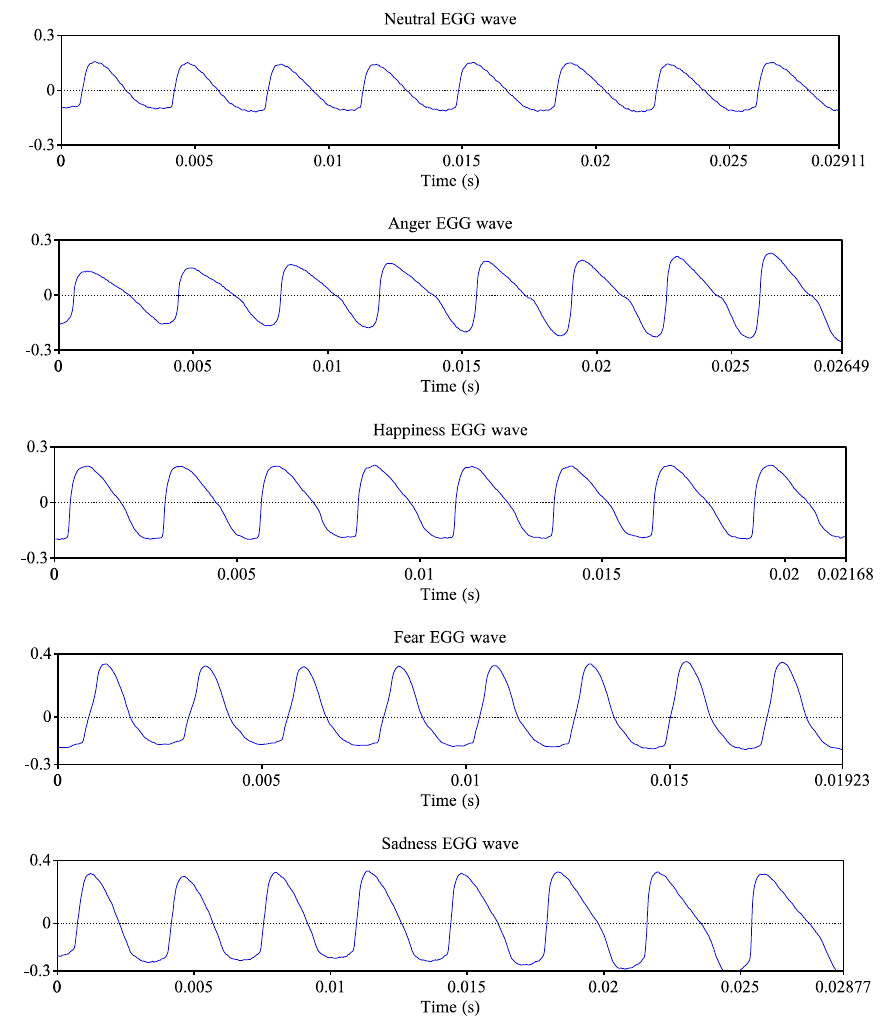
Figure 1. Pitch-normalized EGG waveform of five emotions in Mandarin.